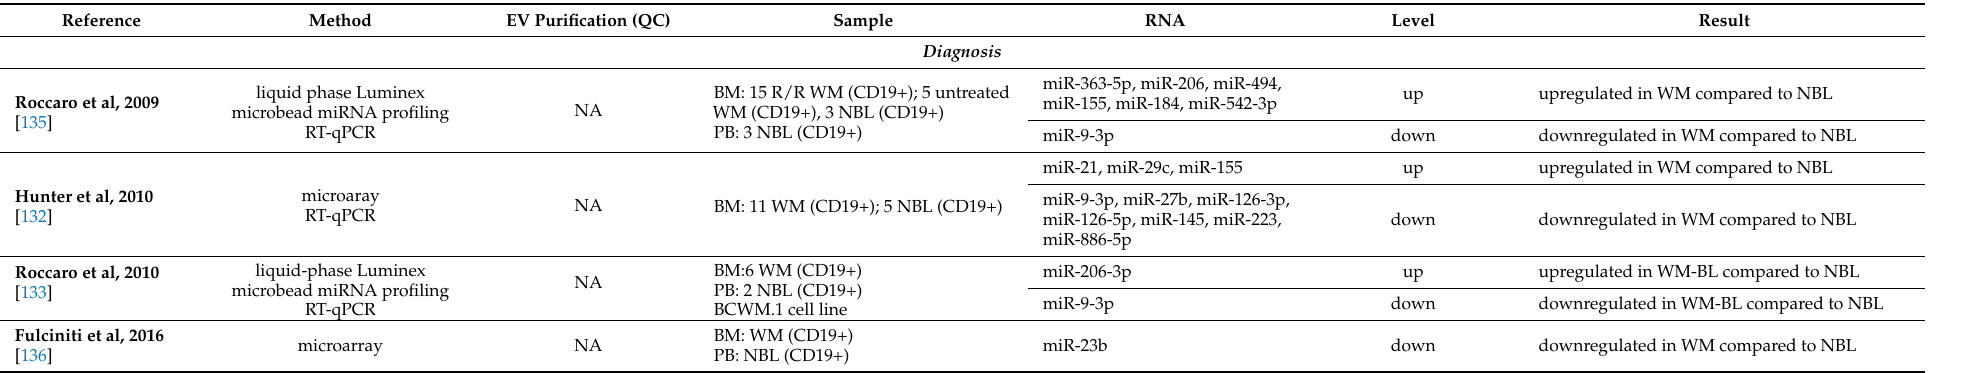
Table 5. miRNA expression in WM. AFM: atomic force microscopy; BL: B lymphocyte; BM: bone marrow; CLL: chronic lymphatic leukemia; DC: differential centrifugation; HC: healthy control; MGUS: monoclonal gammopathy of undetermined significance; MM: multiple myeloma; NBL: normal B lymphocyte; NPC: normal plasma cell; PB: peripheral blood; PC: plasma cell; QC: quality control; RT-qPCR: reverse transcription-quantitative PCR; SMM: smoldering multiple myeloma; TEM: transmission electron microscope; WM: Waldenström